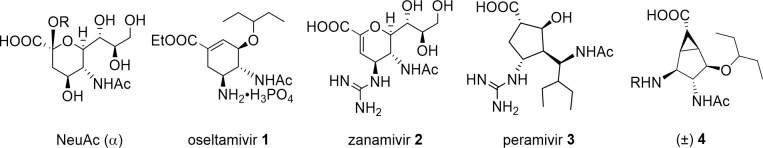
Sialic acid (α configuration), oseltamivir 1, zanamivir 2, peramivir 3 and the bicyclo[3.1.0]hexane scaffold 4.